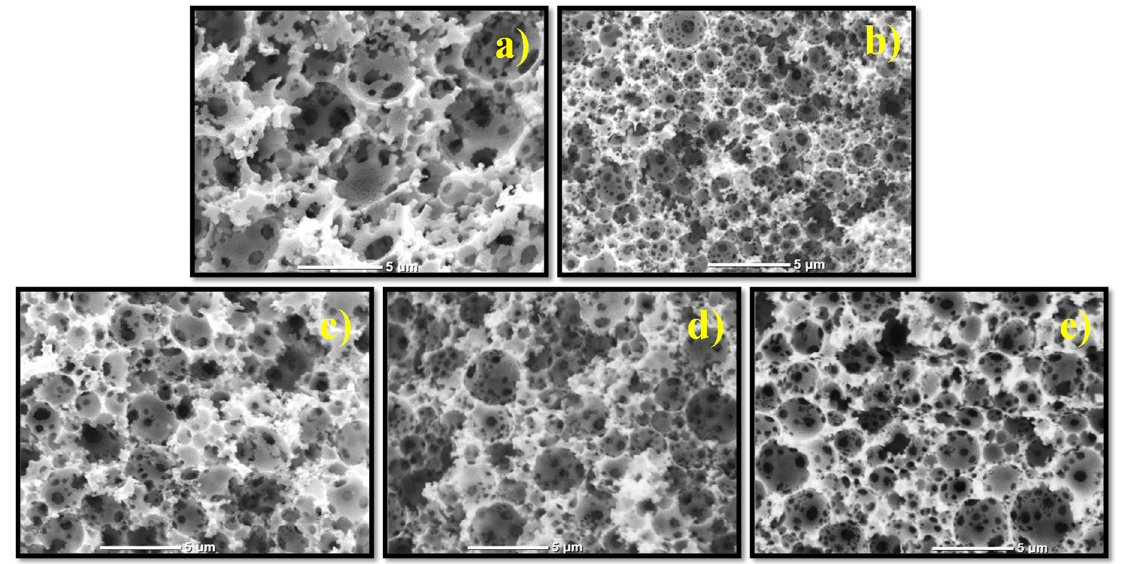
Figure 7. Morphology of obtained monoliths ( a ) T–E (1:3); ( b ) T–I, (1:3); ( c ) T–E–I (1: 1.5:1.5); ( d ) T–E–I (1: 0.9:2.1); ( e ) T–E–I (1: 0.6:2.4).